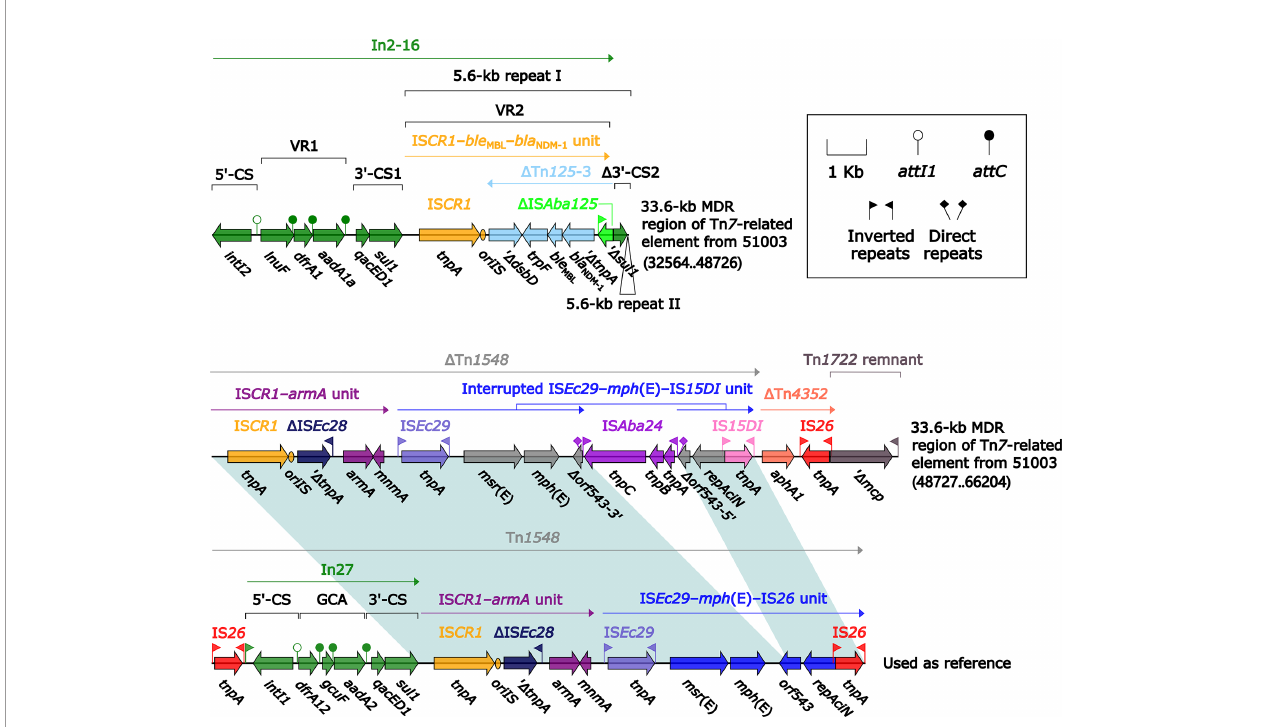
FIGURE 10 | Organization of MDR region from 40.7-kb Tn 7 -related element, and comparison to related regions. Genes are denoted by arrows. Genes, mobile elements, and other features are colored based on their functional classi fi cation. Shading denotes regions of homology (nucleotide identity ≥ 95%). Numbers in brackets indicate nucleotide positions within the chromosome of strain 51003. The accession number of Tn 1548 (Galimand et al., 2005) used as reference is AF550415.